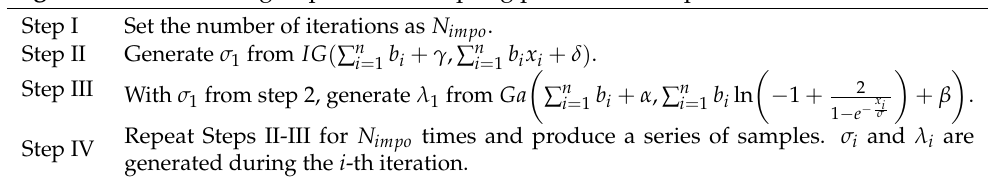
Algorithm 3 Generating importance sampling procedure